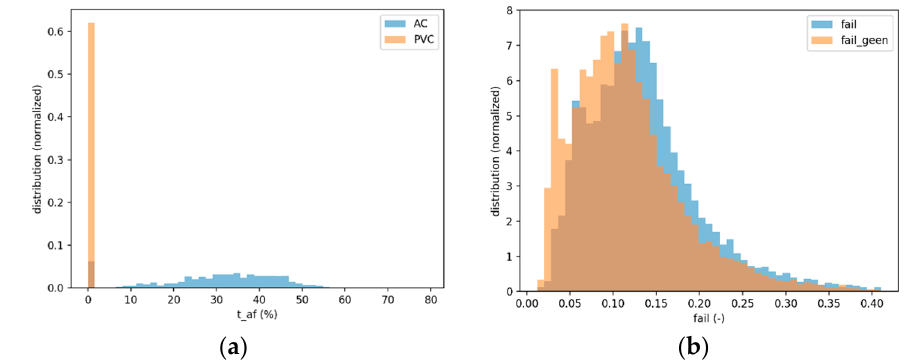
Figure 2. ( a ) Reduction in wall thickness as a percentage of the original wall thickness. ( b ) Distribution of failure parameter (combination of stress and joint rotation) with (blue) and without wall thickness reduction (orange) for AC